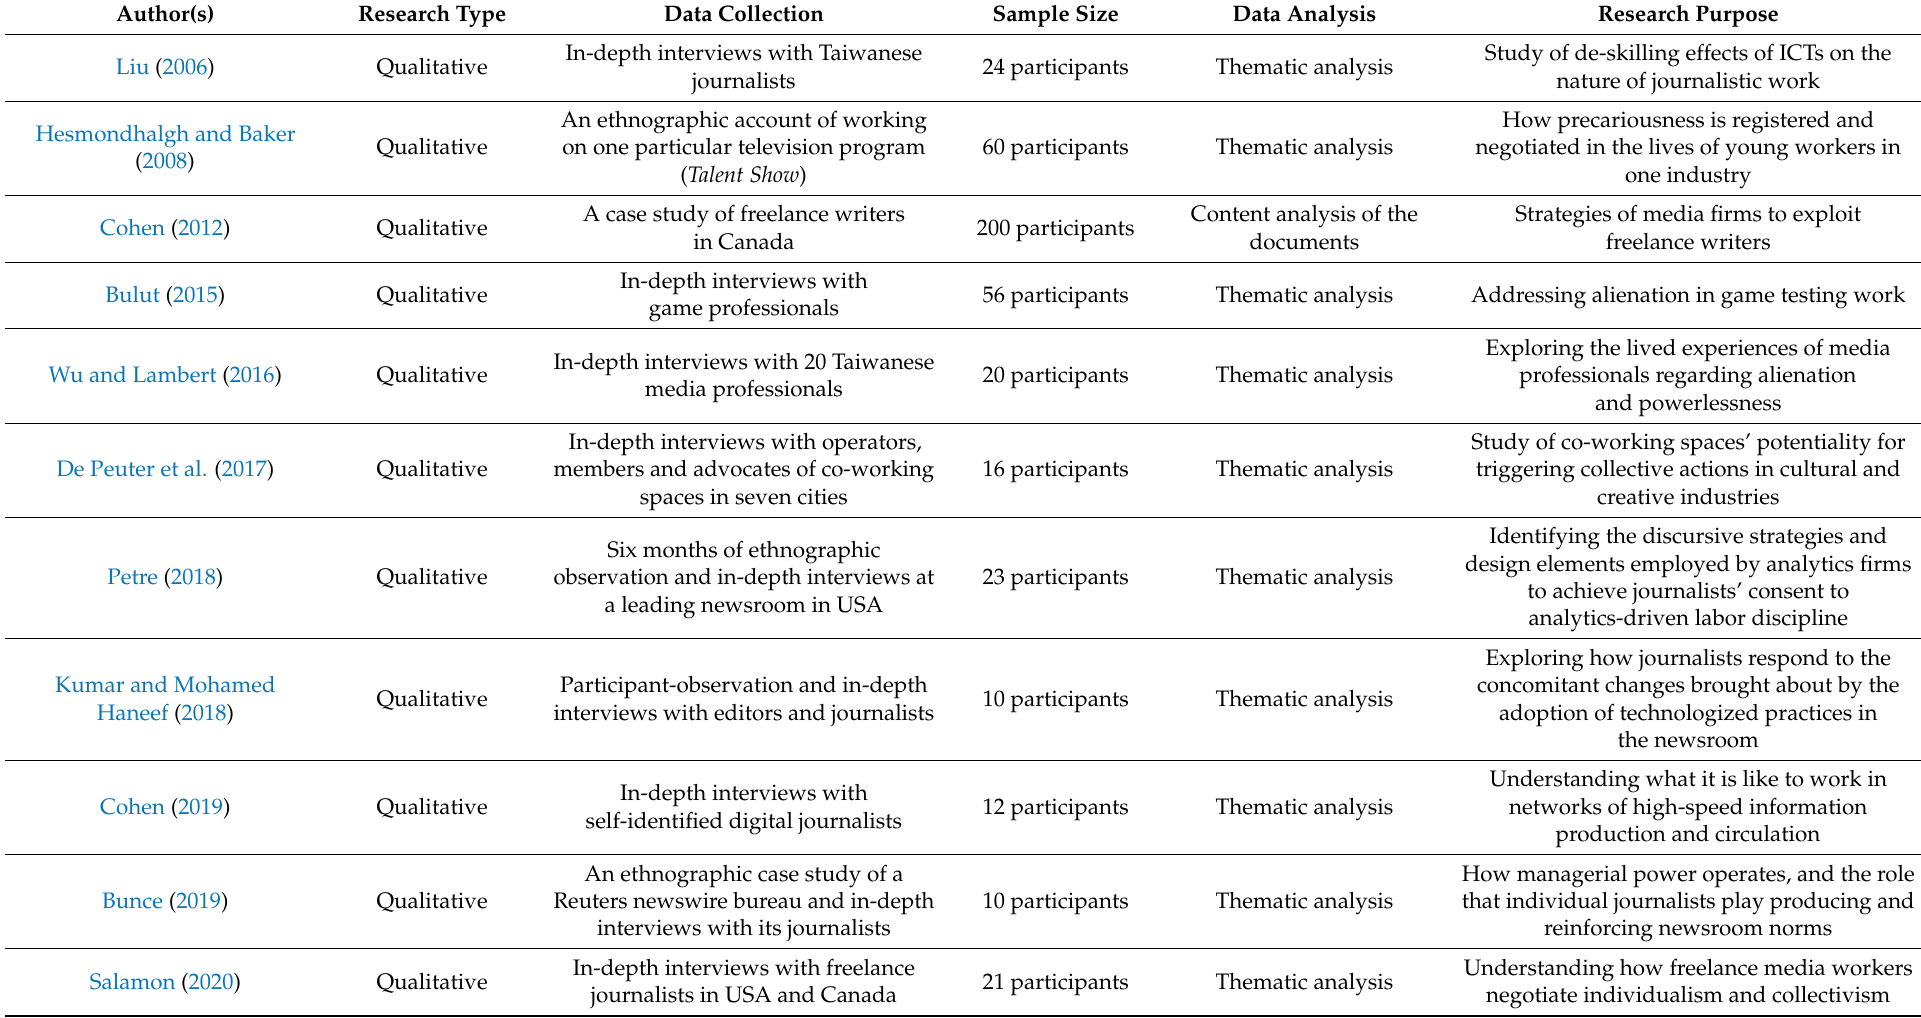
Table 5. Distribution of papers in the subtheme “contested